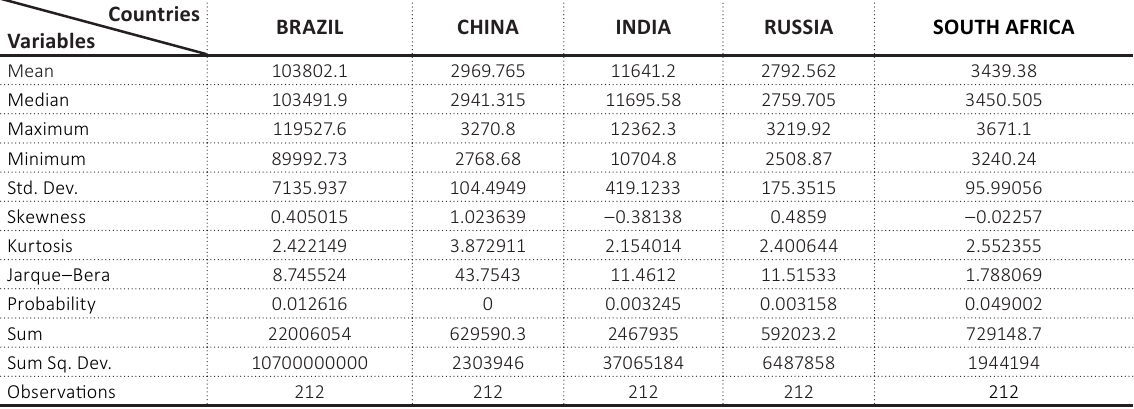
Table 1. Descriptive statistics during the pre-pandemic